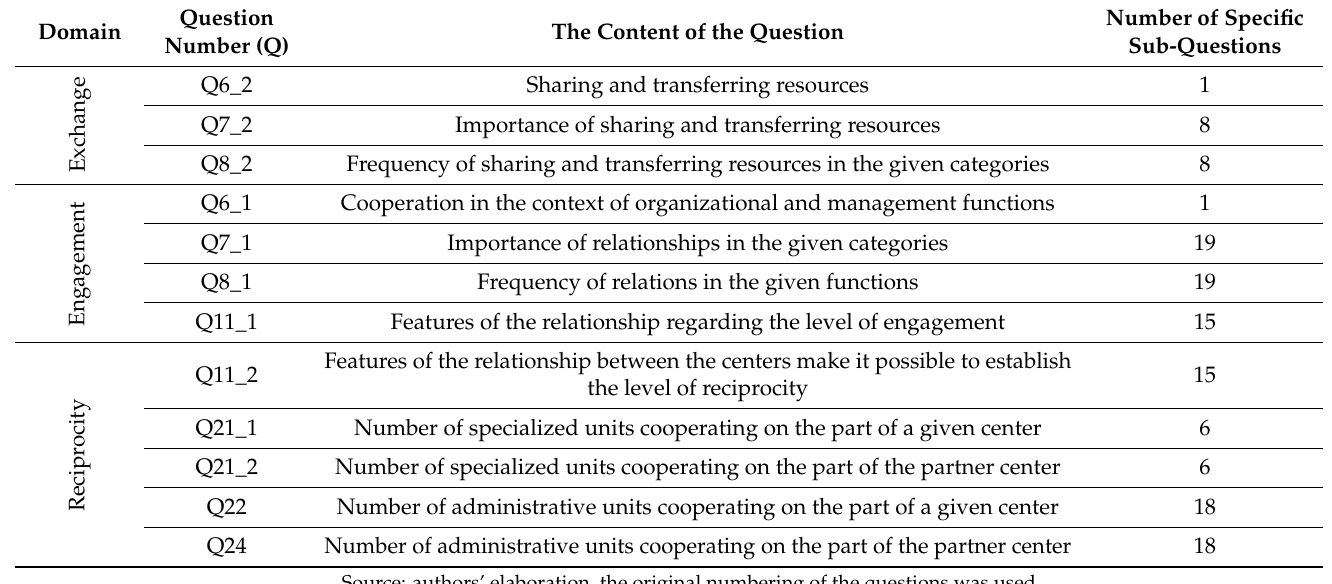
Table 2. Summary of the survey questionnaire questions assigned to each explanatory variable (domains of relationships between units in the